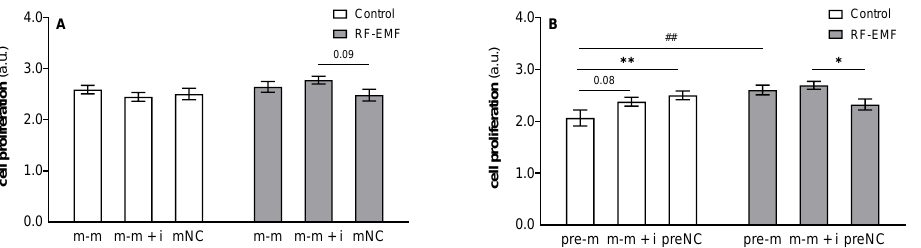
Figure 10. Effect of miR-34a administration on the proliferation of DLD1 cells under control and RF-EMF conditions. Cells were transfected with ( A ) miR-34a-5p (m-m), ( B ) pre-miR-34a (pre-m), mimic of mature miR-34a together with the miR-34a inhibitor (m-m + i) or corresponding negative control of mature and pre-miRNA (mNC and preNC, respectively) and incubated for 48 h; then, cell proliferation was assessed by a colorimetric MTS assay. Data are presented as the mean ± SEM (n = 4). Two-way ANOVA, Tukey’s post hoc test, * p < 0.05, ** p < 0.01, comparison between groups transfected with different oligos within control or RF-EMF treatment. Two- way ANOVA, Š ídák ’ s multiple comparisons test, ## p < 0.01 comparison between control and RF-EMF groups.